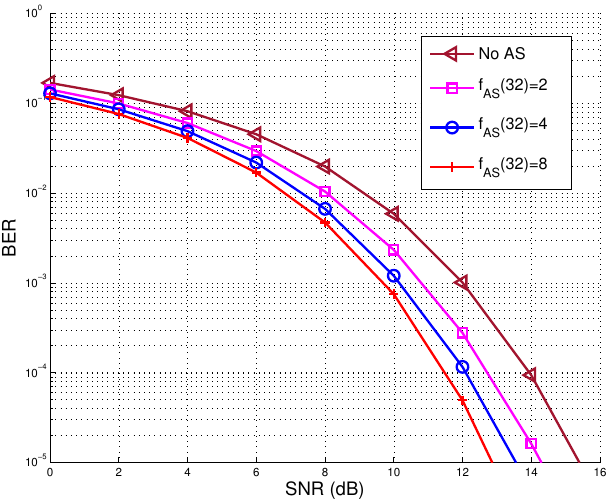
Figure 3. Bit error ratio (BER) performance comparison of proposed Antenna selection (AS) aided multi-user multiple-input multiple-output (MU-MIMO) system associated with K = 8 active users, N T = 32 transmit radio frequency (RF) chains, and various AS factor, in comparison to that of conventional MU-MIMO without